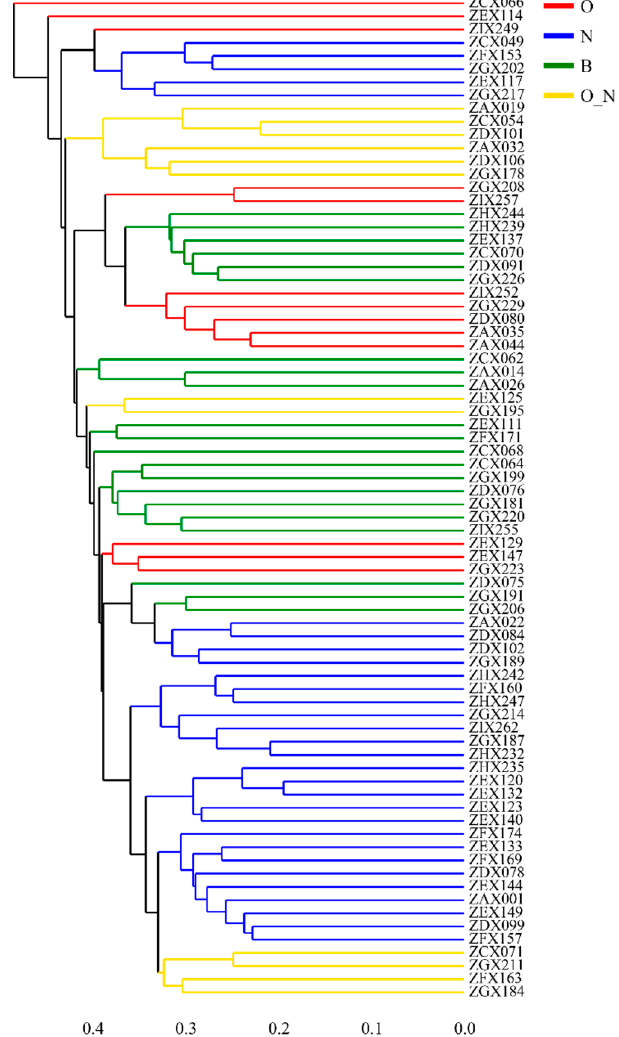
Figure 4. Hierarchical clustering tree on operational taxonomic unit (OTU) level.